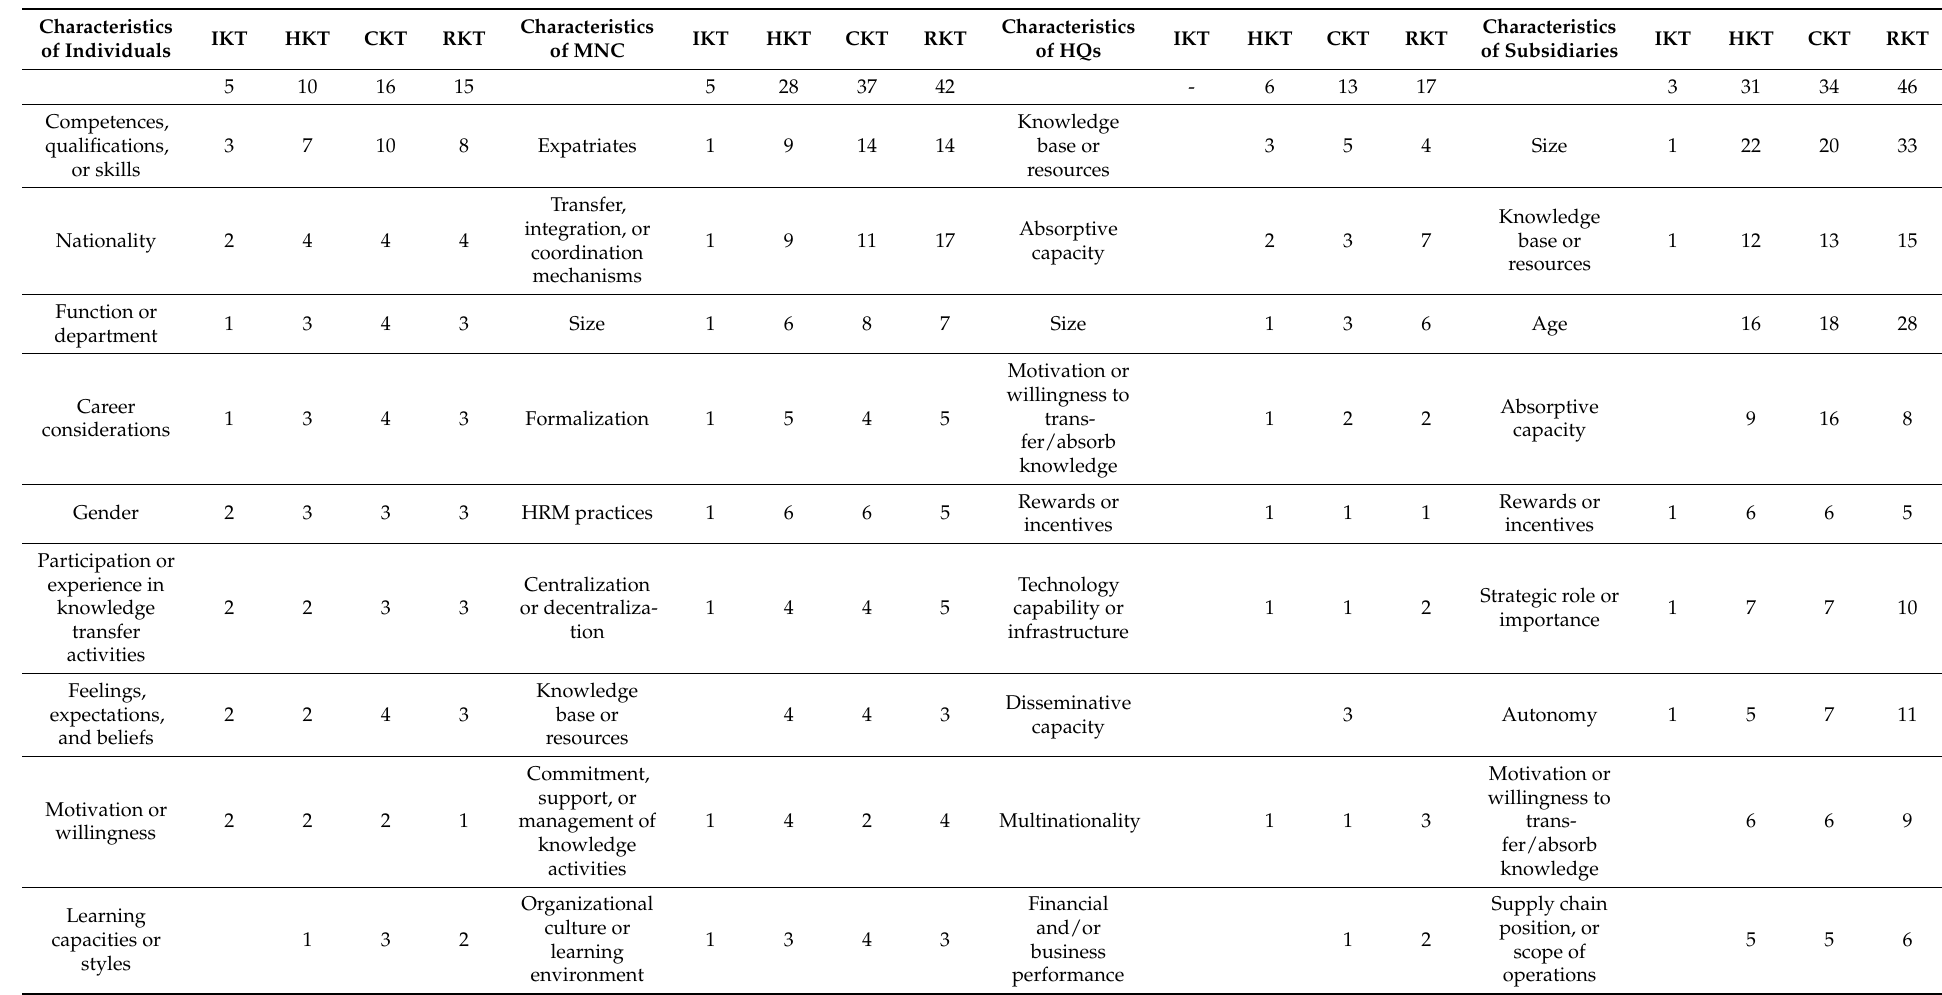
Table 1. Categories and topics